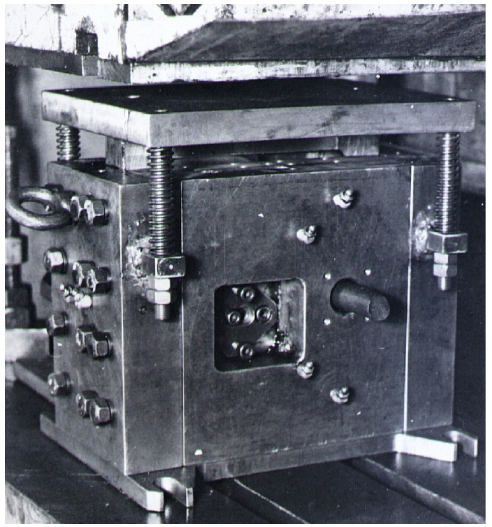
Figure 7. Photo of the stamp with the differentiated clamp of the rolled stock